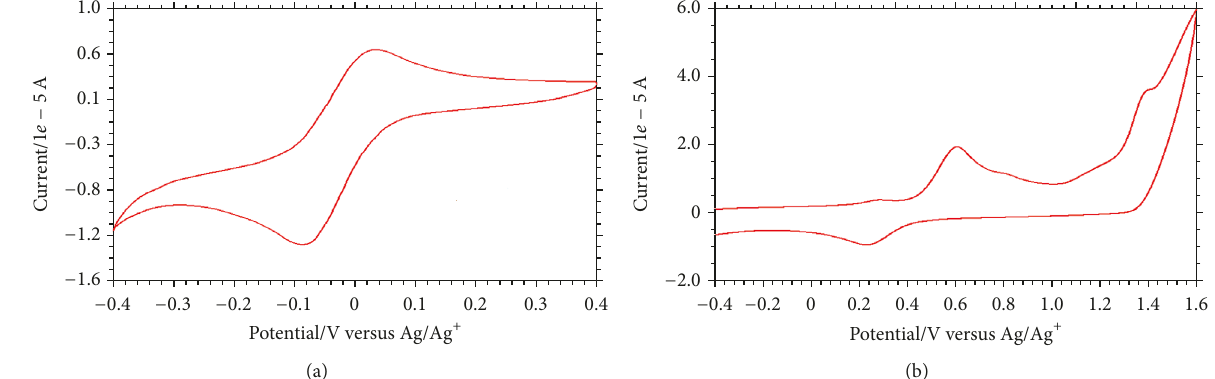
Figure 6: Cyclic voltammogram (a) of CuL 2 and (b) of NiL 2 in dichloromethane containing 0.1 M TBAHFP. Scan rate 100mV/s.